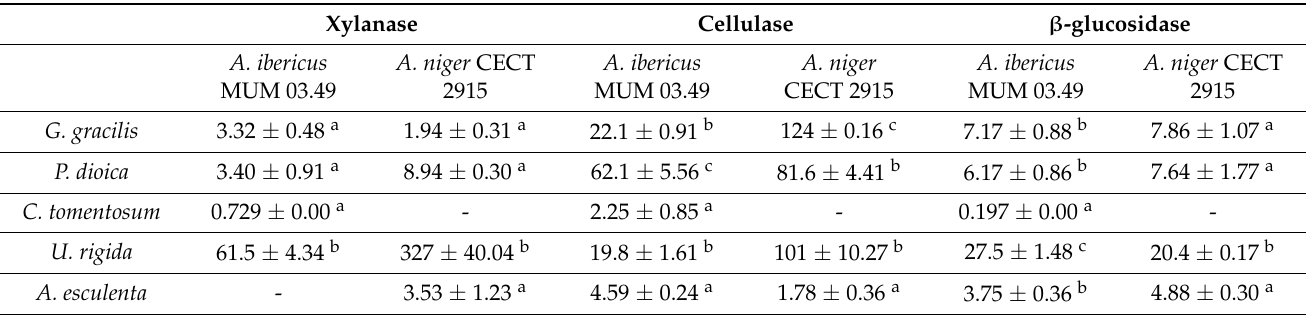
Table 4. Enzyme production by solid-state fermentation of the different seaweeds (U g − 1 dry fermented seaweed).